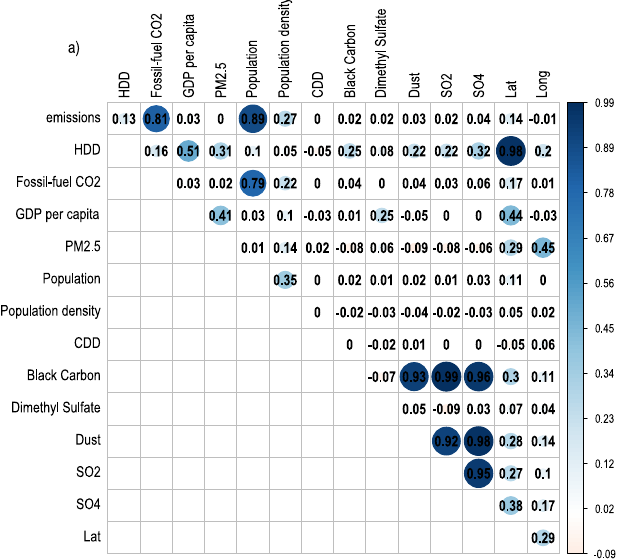
Fig. 1 | Predictors of European cities ’ emissions. a Correlation matrices showing the relationship between various predictors of urban climate emissions. b Importance of various predictor variables to the emissions ’ prediction model.